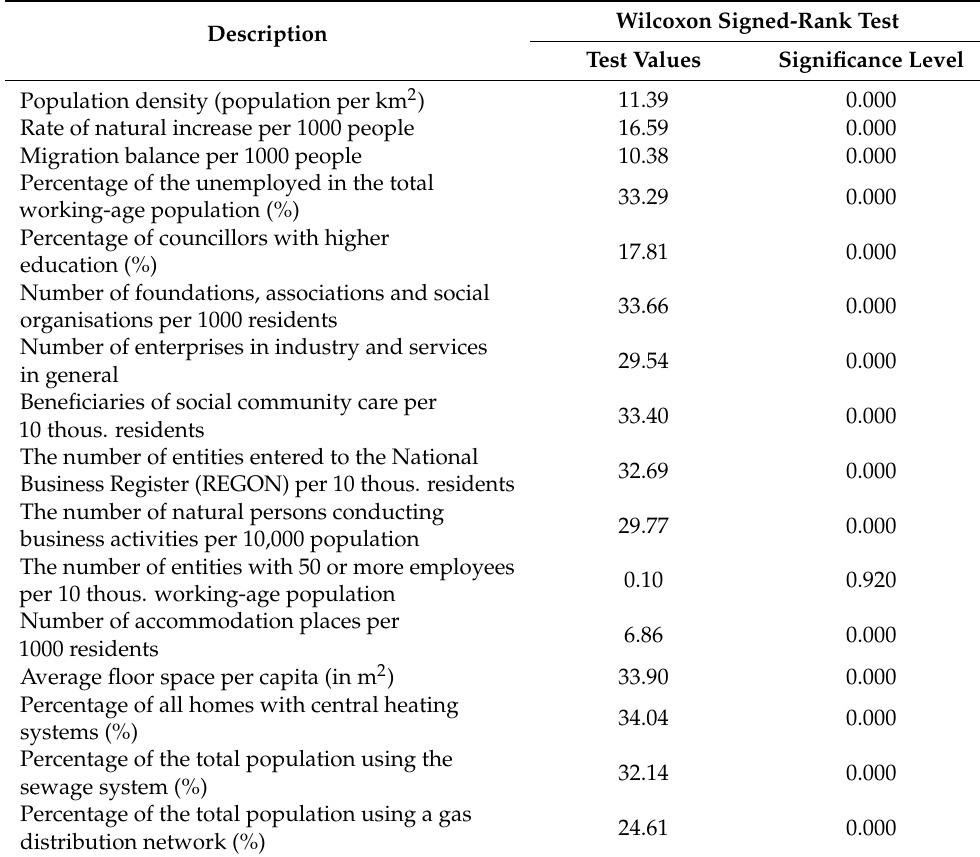
Table 6. A comparison of dependent samples in terms of the socio-economic situation of rural communes in Poland in the years 2007–2009 and 2016–2018 (results of the Wilcoxon signed-rank test).